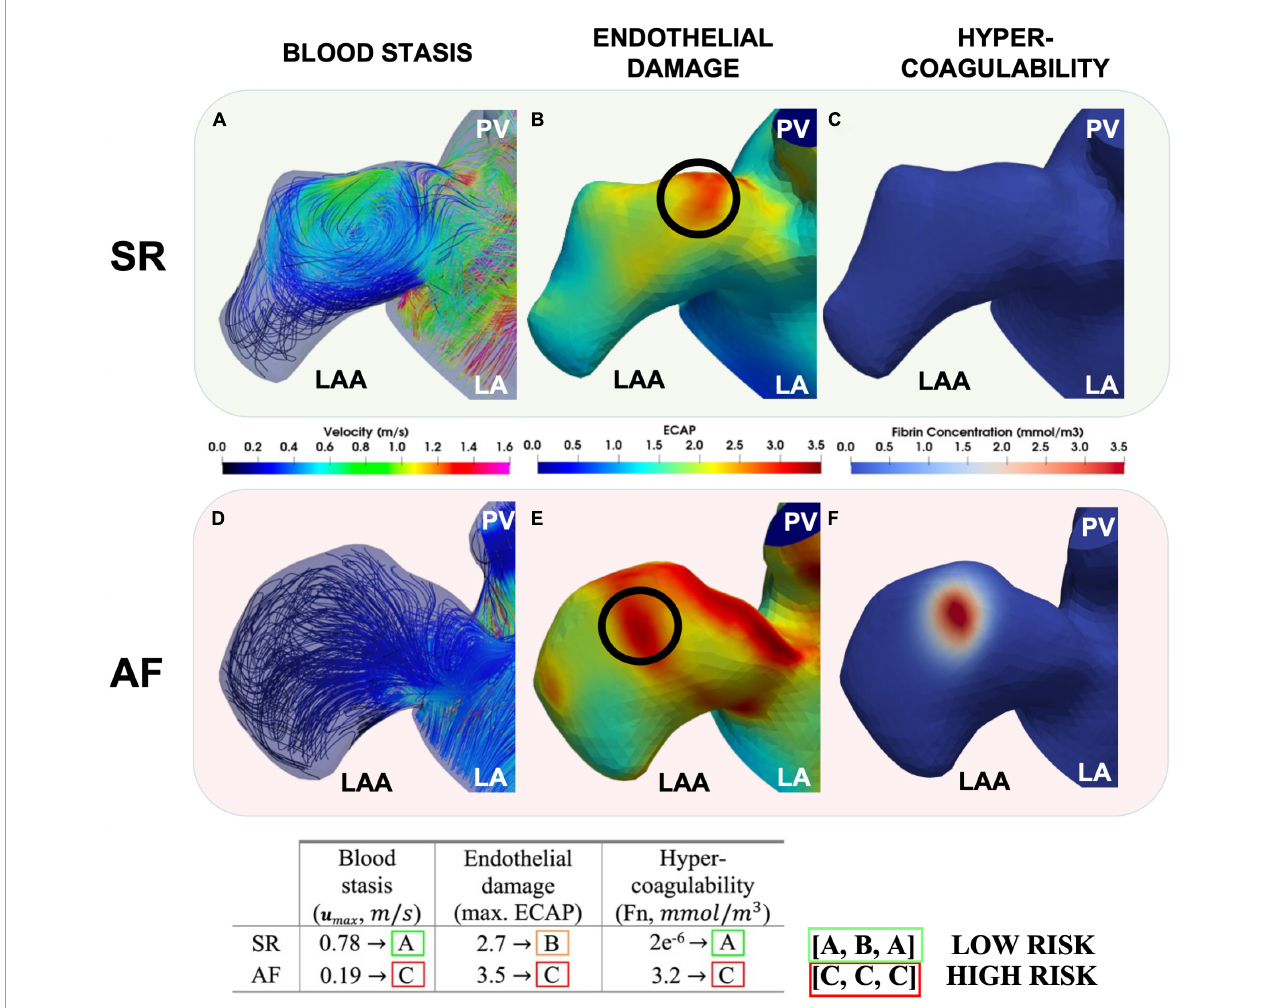
FIGURE6 Modelling each aspect of Virchow’s triad. The LAA during SR (top row) and AF (bottom row). Peak LAA blood flow velocities (A,D) , ECAP with the location of the maximum ECAP chosen to initiate coagulation [ (B,E) and black circles] and fibrin thrombus growth due to coagulation after 4 cardiac cycles shown (C,F) . Modelling of Virchow’s triad-based mechanistic risk profile also suggested per patient (In Press – Computing in Cardiology